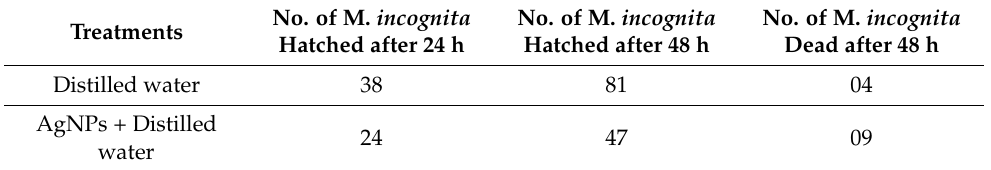
Table 2. Effect of AgNPs on nematode, M. incognita